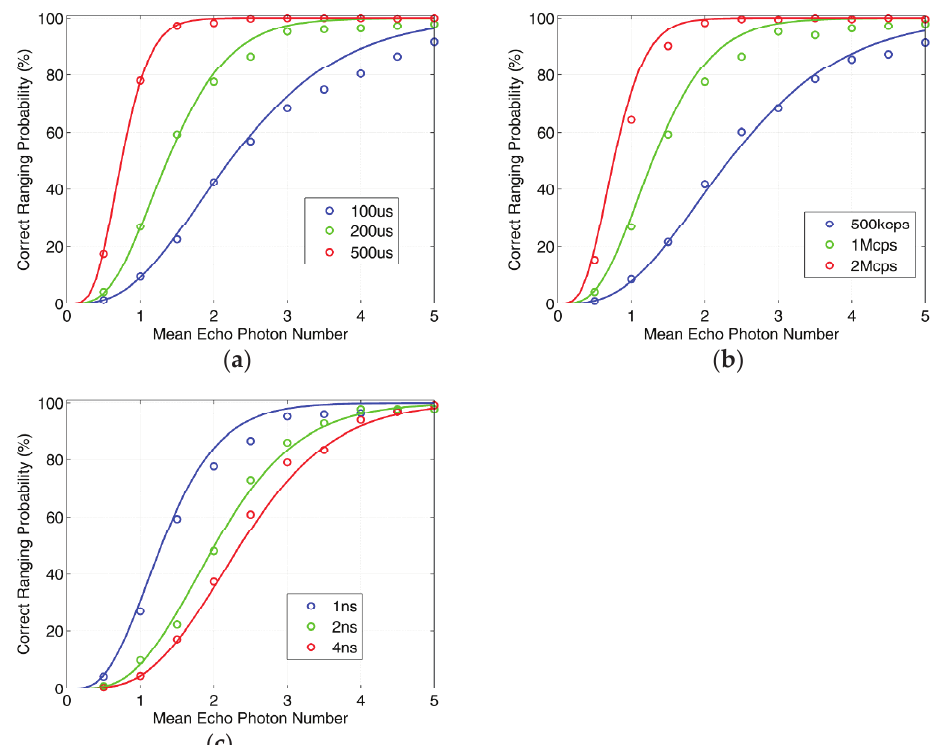
Figure 10. Experimental verification of correct ranging probability under different system parameters: ( a ) the influence of sequence length on correct ranging probability (mean pulse count density 1 Mcps, pulse width 1 ns, mean noise count density 1 Mcps), ( b ) the influence of mean pulse count on correct ranging probability (sequence length 200 µ s, pulse width 1 ns, mean noise count density 1 Mcps), ( c ) the influence of pulse width on correct ranging probability (sequence length 200 µ s, mean pulse count density 1 Mcps, mean noise count density 1 Mcps).